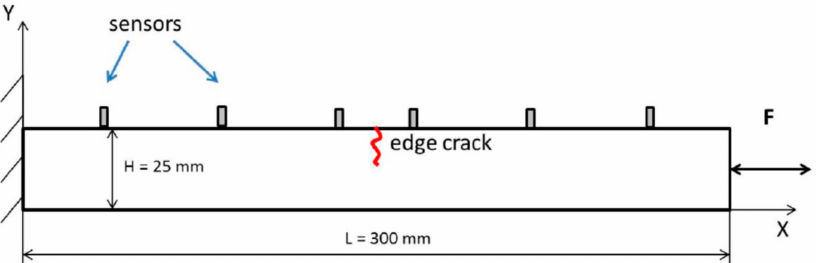
Figure 2. Schematic view of the beam used in FE simulations. Please note that the size and location of the crack, as well as the locations of sensors along the beam, depend on various simulation arrangements